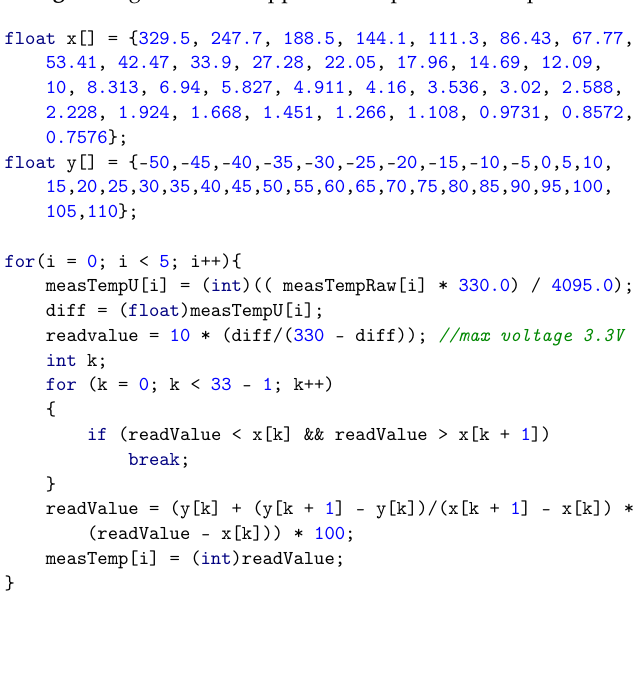
Figure 9. The measured temperature according to real temperature in the smart IoT device The most important group of sensors are flow sensors, which enable flow measurement 480 on all copper tubing inside the python tube. With the help of these sensors, it is possible 481 to measure the consumption of beverages and determine the amount of liquid that has